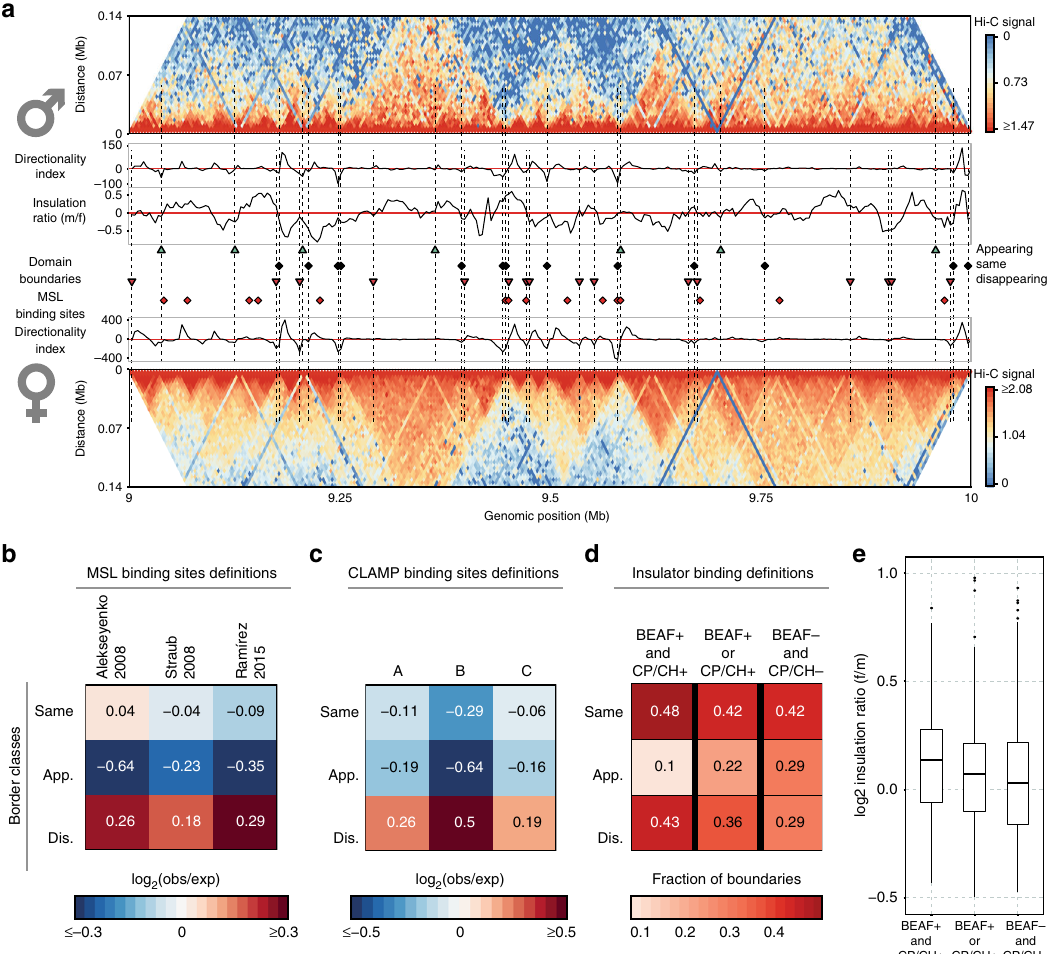
Fig. 4 Changing domain borders are associated to dosage compensation features. a Example of domain borders identi fi ed by LSD classi fi ed by their concordance between male and female samples in sex-sorted embryos Hi-C data (binned at 3.5 kb, normalized by chromosome-wise ICE). A representative 1 Mb region of chrX is shown, with contact frequencies (colour bars on the side) for male (upper half) and female (lower half) data. The directionality index is shown adjacent to the Hi-C maps. Domain boundaries are marked based on their detection in male or female sample: disappearing (red triangles), appearing (green triangles) and same, i.e. unchanged (black diamonds) domain boundaries. MSL binding sites are also marked